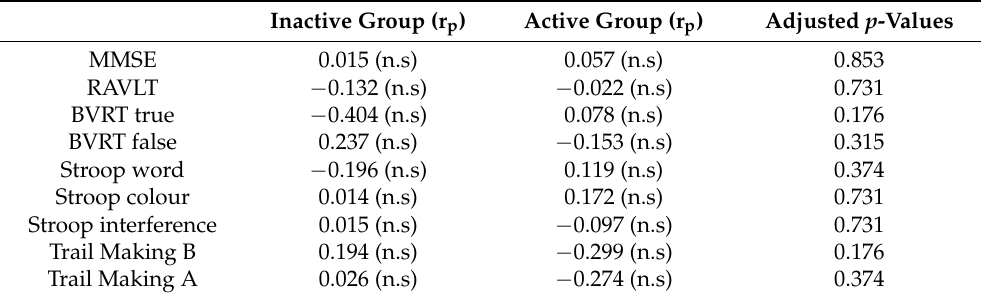
Table 2. Partial correlation coefficients (adjusted statistical significance) and adjusted p -value from the comparison of coefficient correlation between